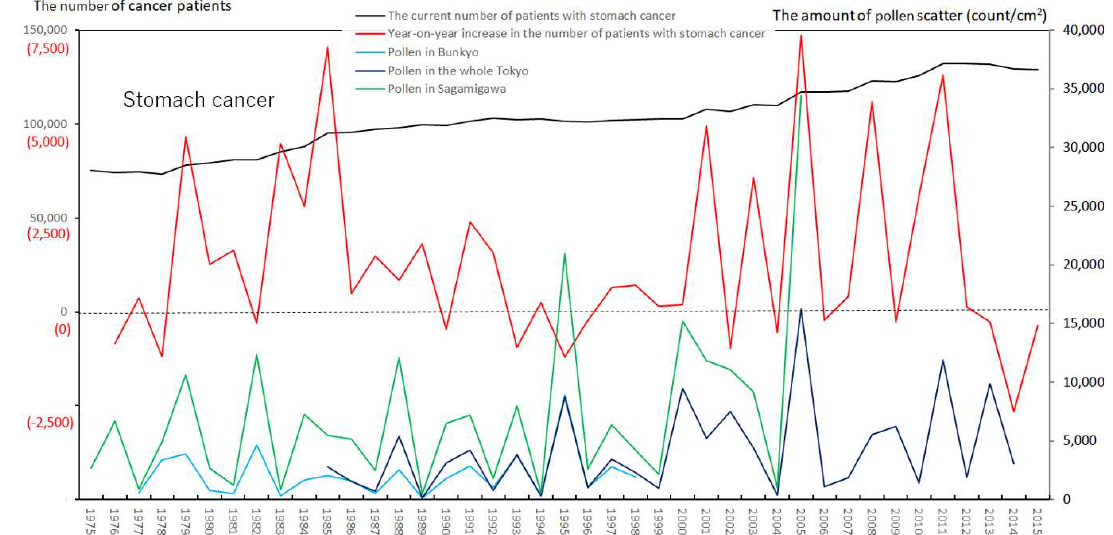
during the period from 1975 to 2015. Violet or orange arrows indicate phasic increments of newly registered patients occurring two or six years after phasic increments of airborne pollen scatter, respectively.